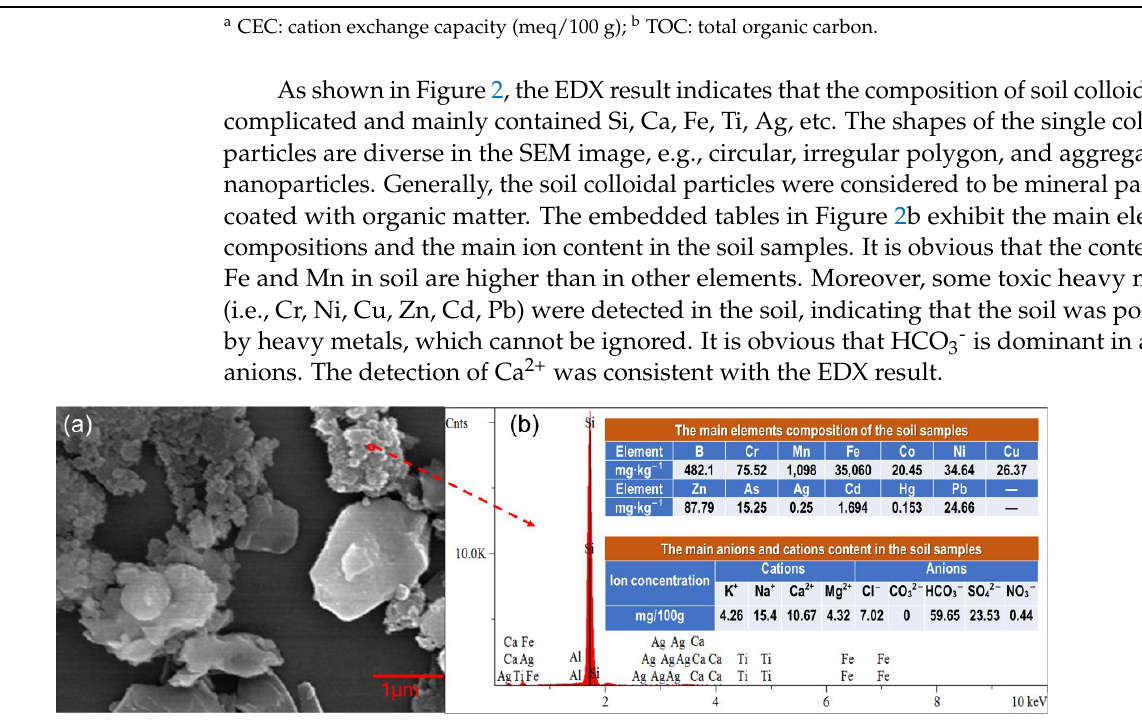
Figure 2. ( a ) SEM images of soil colloids; ( b ) EDX of soil colloids and the embedded tables are the main element compositions and the ion content in the soil samples.